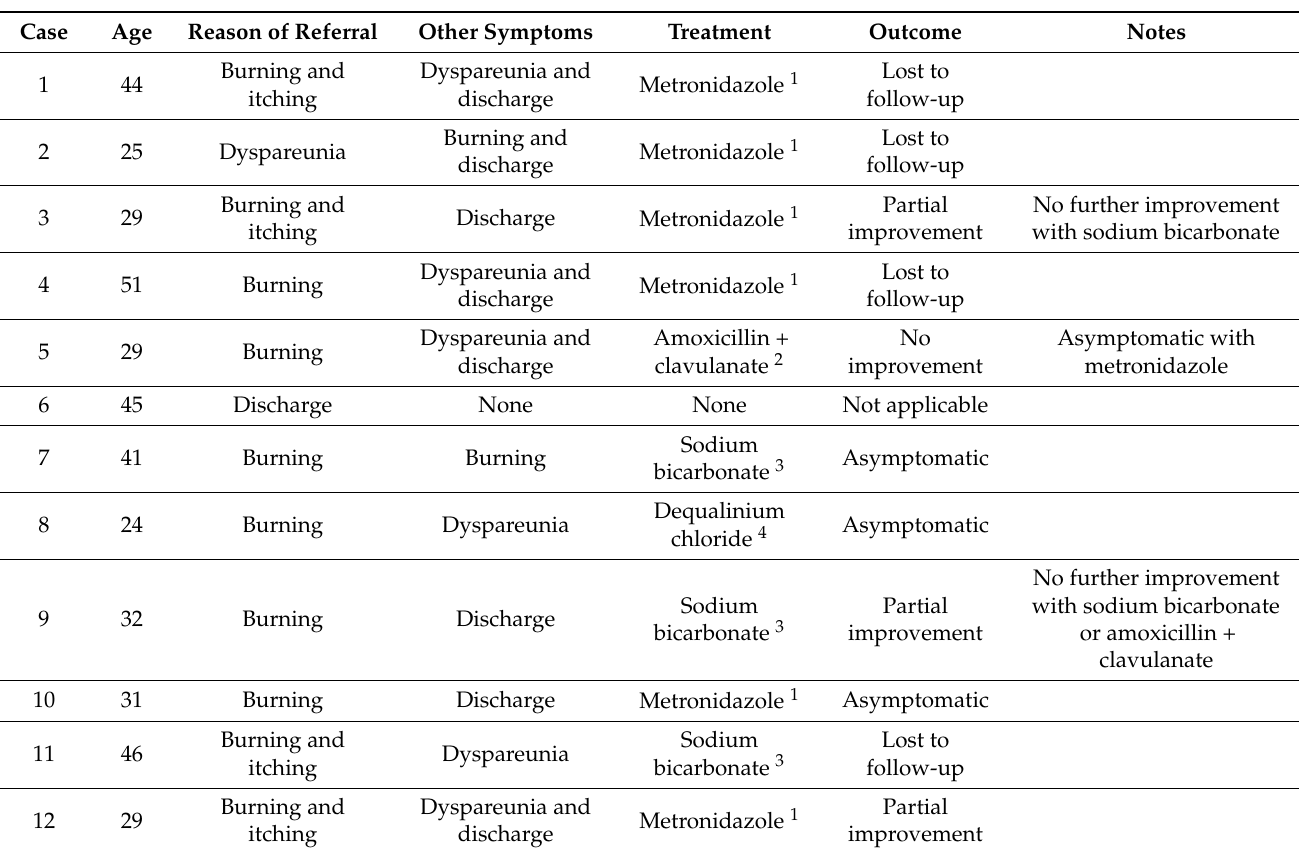
Table 2. Age, reason for referral and additional symptoms, treatments prescribed, and outcome